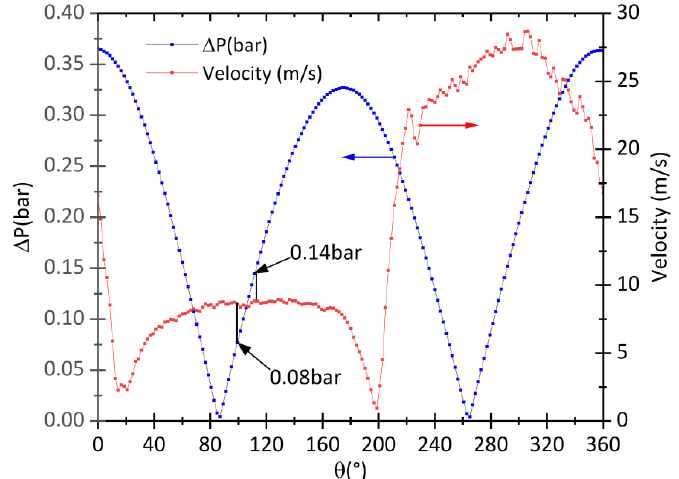
Figure 12. The angular phase shift between pressure drop and velocity of regenerator (Str_40%, L 1 = 60 mm, C 1 = 64.4 mm) versus phase for temperature gradient Δ T 1 = 70 °C/ 10 °C and Fr = 5.74 Hz.